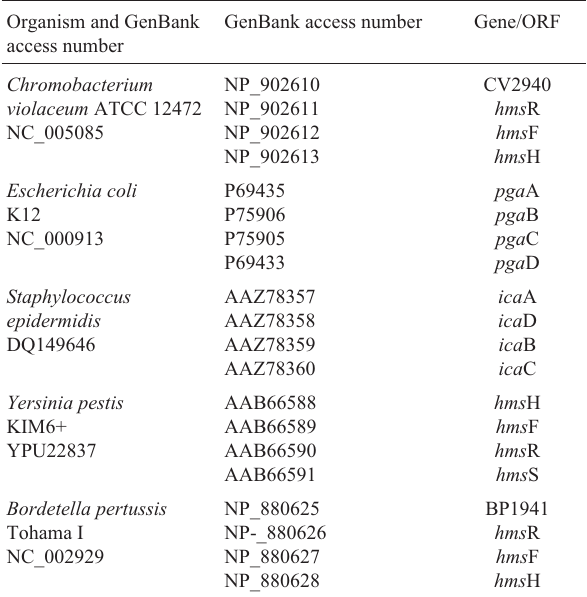
Table 1 - Bacteria with their genomic regions used in the comparative study. Organism and GenBank access